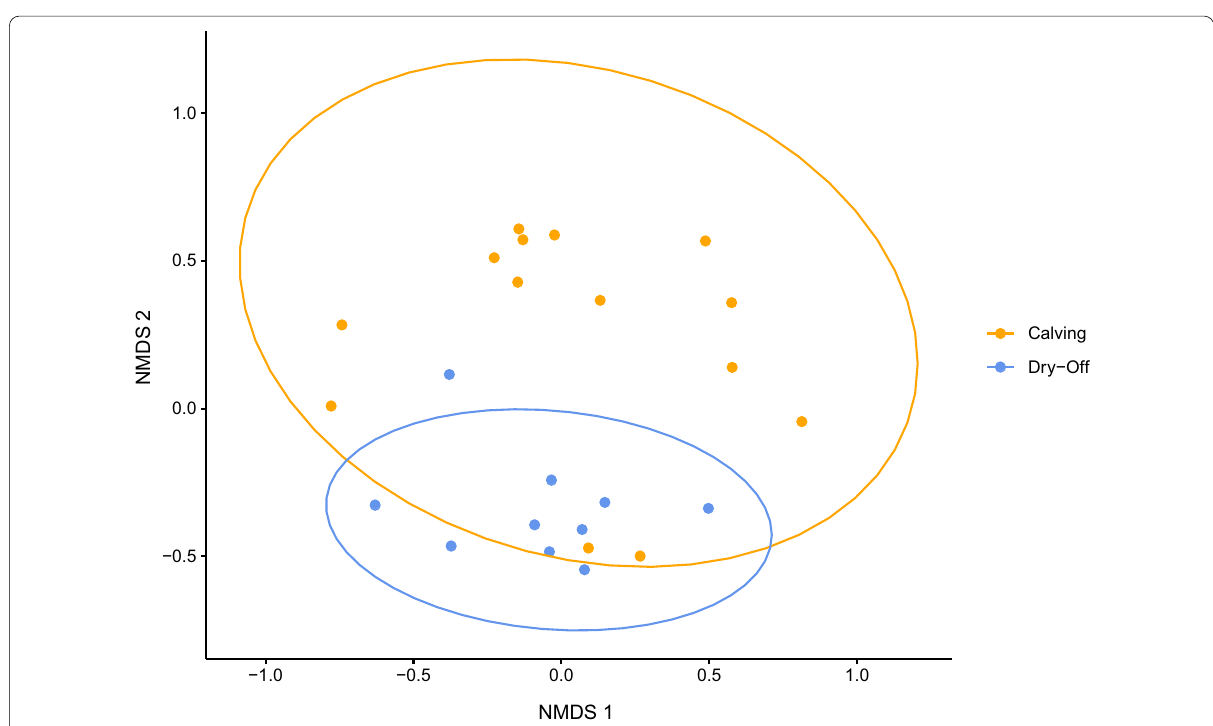
Fig. 4 NMDS plots showing distinct clustering when comparing drying off and calving milk samples across all treatments